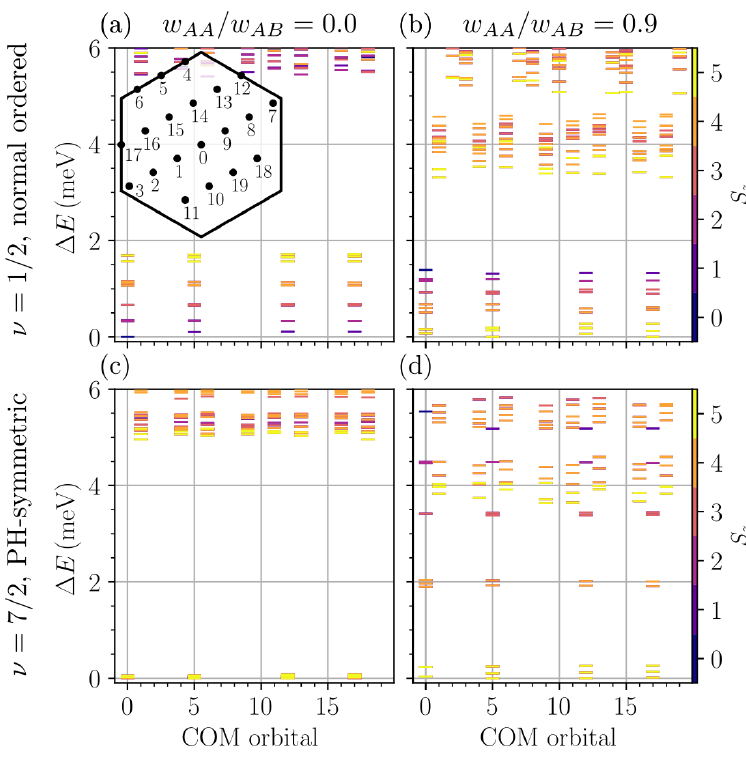
Figure 9: Spin resolved many-body spectrum of TDBG for pure interactions at η “ 0 on the N “ 20 (C20) cluster. The system is at filling ν “ 1 { 2 [ ν “ 7 { 2 ] with normal [ particle-hole symmetric H PH ] interactions at (a) [ (c) ] w ordered H NO int int { w “ 0.9. The slight asymmetry of the energy levels at as well as (b) [ (d) ] w AA AB different M points is rooted in the lack of C symmetry of the simulation cluster j 3